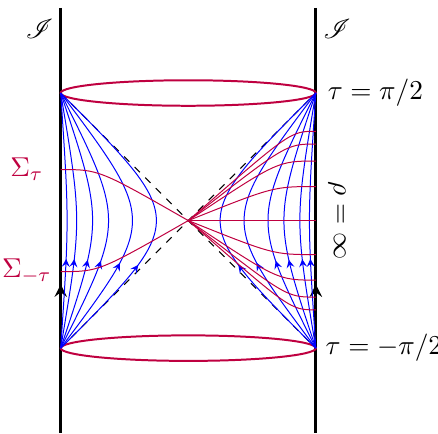
Figure 1 . The patch of AdS d covered by hyperbolic coordinates. Blue curves are constant (cid:26) hypersurfaces, preserved by SO( d (cid:0) 1 ; 1) Lorentz transformations and the red lines represent codi- mension one constant time (cid:28) slices, in particular (cid:6) (cid:28) ; (cid:6) (cid:0) (cid:28) are two surfaces at (cid:28) and (cid:0) (cid:28) . Note that in our coordinate system all constant time slices for (cid:12)nite (cid:28) pass through (cid:26) = 0. The arrows on the boundary and on blue curves show the (cid:13)ow of time (cid:28) . In this coordinate system, AdS conformal boundary is a maximally symmetric manifold (dS d (cid:0) 1 at (cid:26) ! 1 ), and it is conformally invariant under \AdS-translations". In this (cid:12)gure the left and right vertical lines respectively denote the North and South poles of the S d (cid:0) 2 at the boundary. The points on the left and right vertical lines together with (cid:28) ! (cid:0) (cid:28) are mapped onto each other by the PT transformations, the antipodal